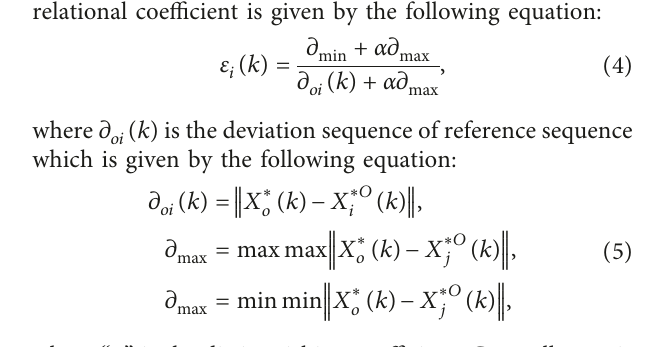
Figure 2: Steps in the composite preparation. (a) Sic powder. (b) Melting of metal. (c) Pattern making. (d) Sand mould preparation. (e) Cope and Drag preparation. (f) Poring metal. (g) Solidification. Table 2: Experimental setup